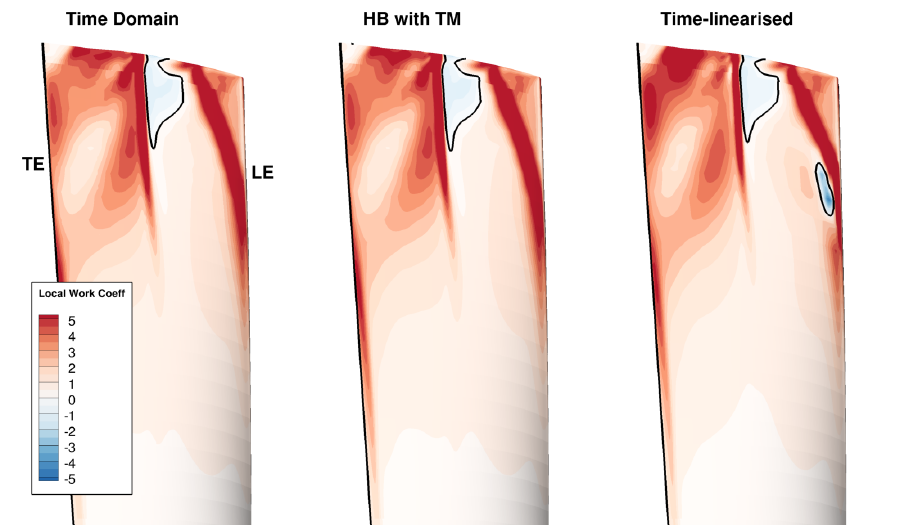
Figure 8. Local work coefficient for σ = − 72 ◦ on the upper half of the suction side, predicted by time-domain, harmonic balance, and time-linearised solvers. Black lines mark the boundaries between stable and unstable areas.